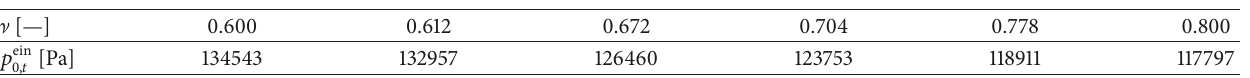
Table 6: The operating points of total pressure at the inlet as a variable in the range of run number ] between 0.3 and